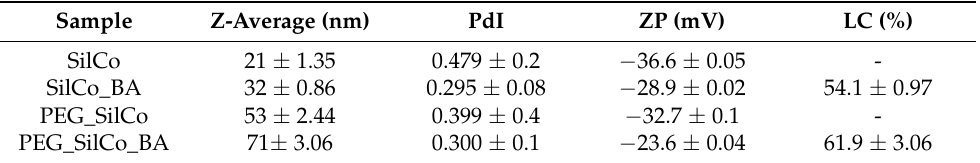
Figure 1. UV–Vis absorbance spectra for the aqueous dilutions (1/10 v / v ) of: ( a ) the silver nanocolloids loaded with betulinic acid and ( b ) the PEGylated silver nanocolloids loaded with betulinic acid. Insets display the aliquot samples of the two silver nanocolloids in glass vials and the expanded spectral areas of the characteristic SPR peaks at 403 and 432 nm, respectively, together with their absorbance values. Table 1. Specific physicochemical characteristics of the silver and polyethylene glycol (PEG)ylated nanocolloids empty and loaded with betulinic acid.